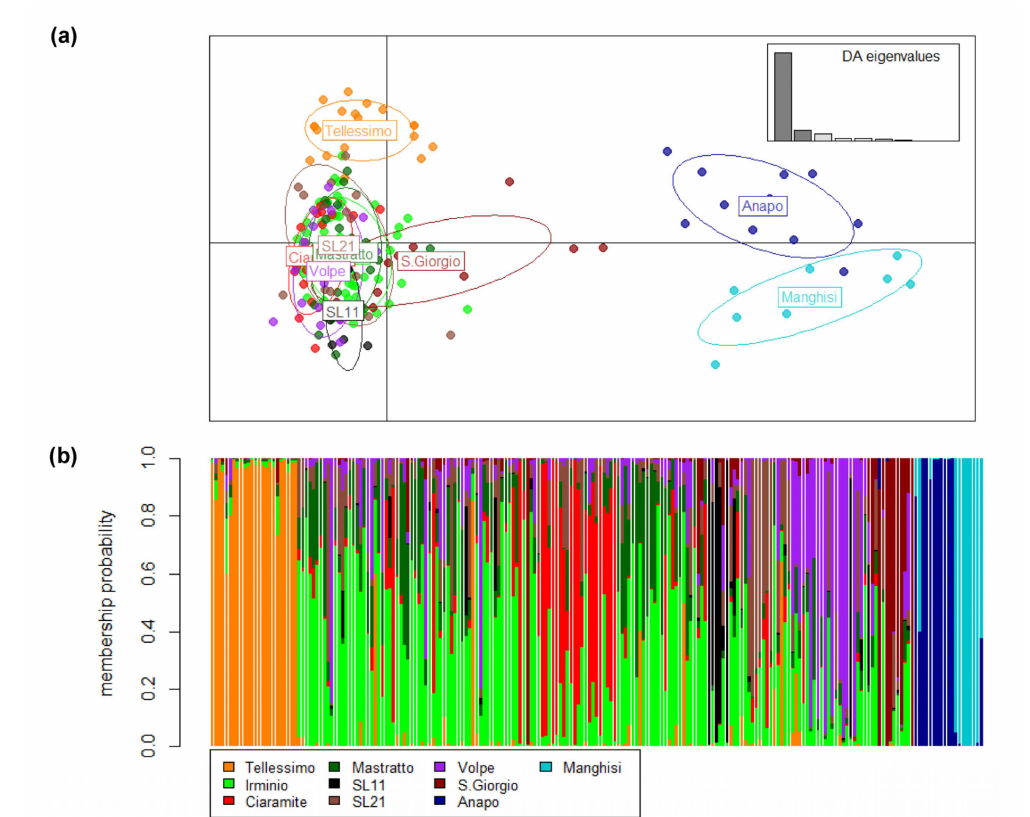
Figure 4. ( a ) Discriminant analysis of principal components (DAPC) of the 213 trout individuals. The right inset displays the DA eigenvalues in relative magnitude. ( b ) Probability of the cluster assignment for the DAPC with all individuals considering 11 populations. Each individual is represented as a vertical bar partitioned into segments colored according to its population